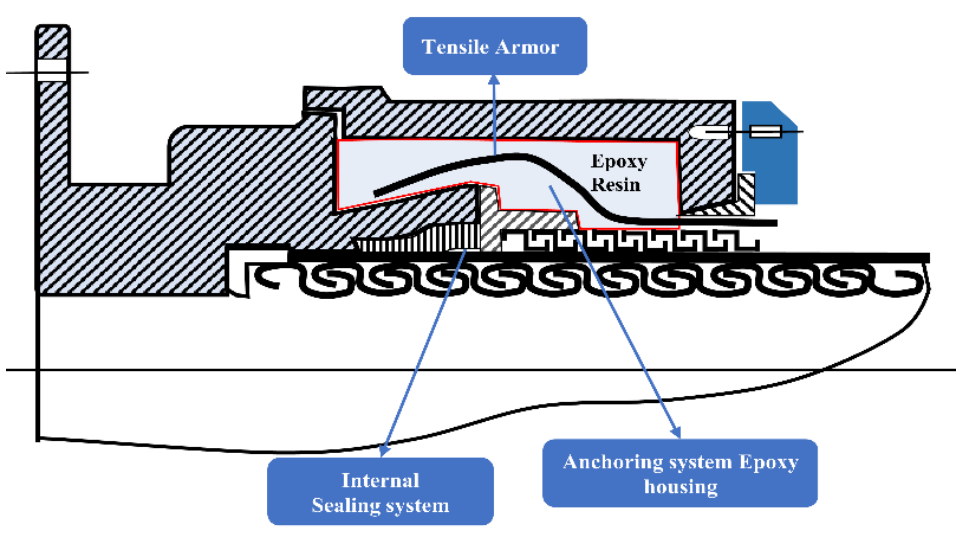
Figure 2. End fitting structure diagram.